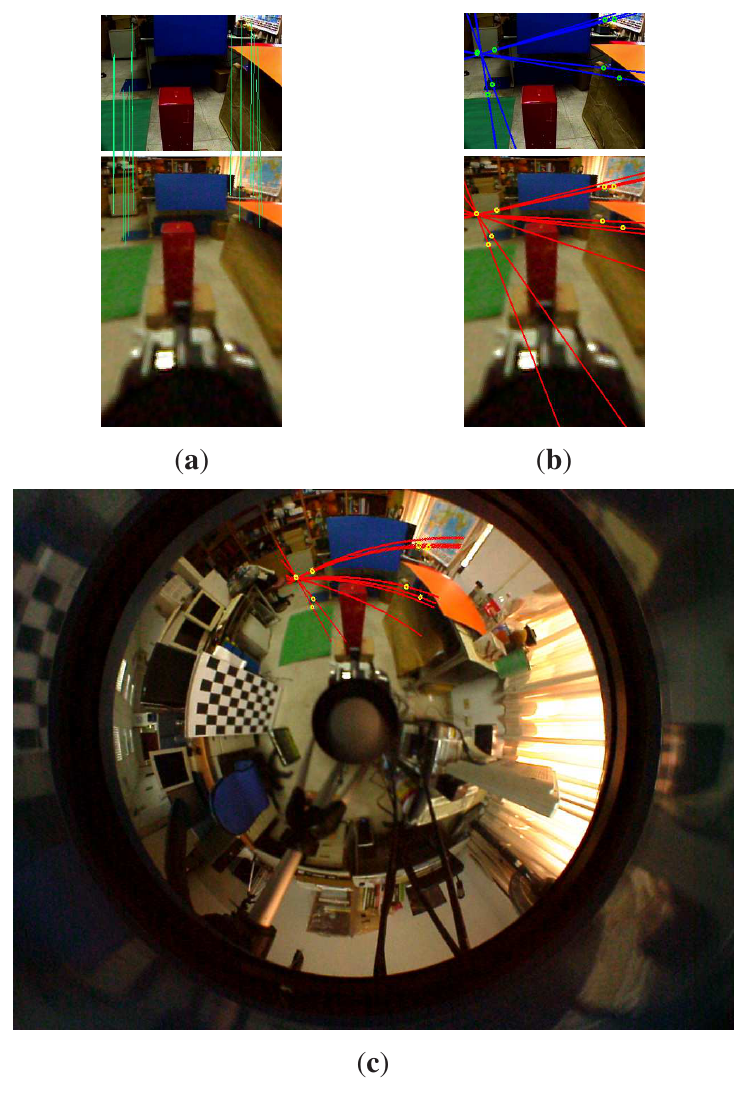
Figure 10. The epipolar geometry of the hybrid omnidirectional and perspective image pair. Figure 10a illustrates the SIFT correspondences between the perspective and virtual images. The epipolar line pairs between the perspective and virtual images are shown in Figure 10b. The corresponding epipolar lines on the omnidirectional image are illustrated in Figure 10c. ( a ) Feature matching; ( b ) epipolar lines; ( c ) the corresponding epipolar lines on the omnidirectional